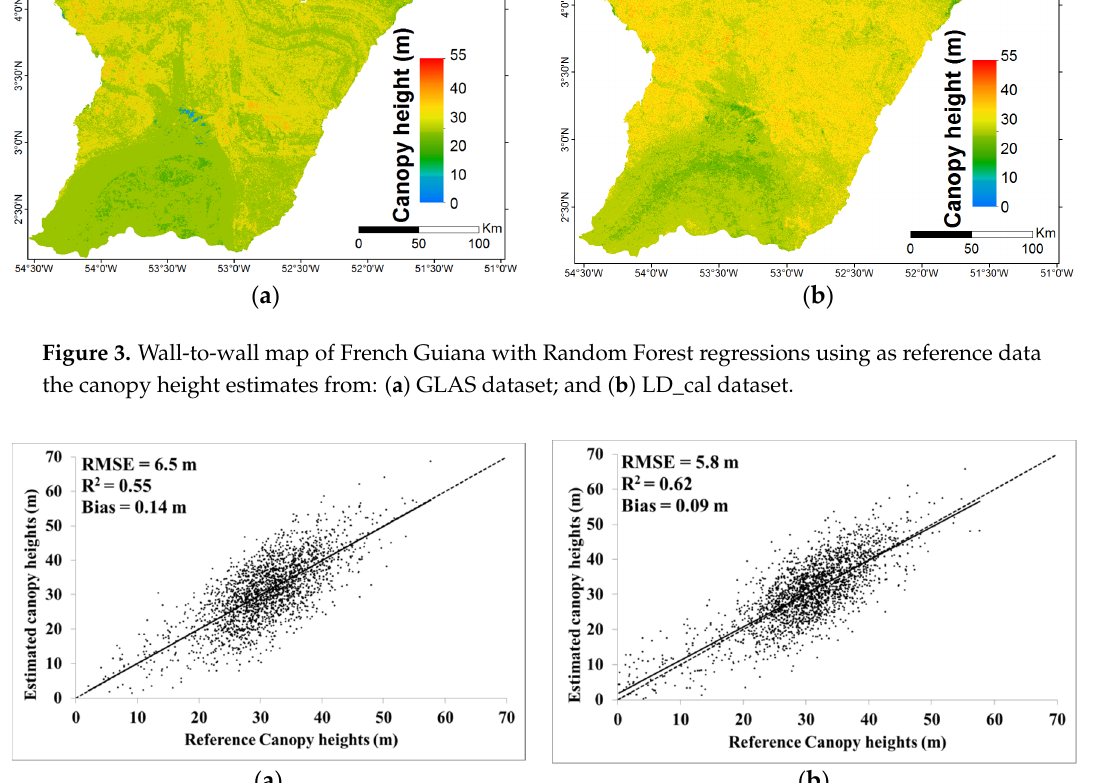
Figure 4. Comparison between the reference canopy heights of the verification datasets and the canopy height trend estimates using Random Forest: ( a ) GLAS dataset; and ( b ) LD_cal dataset. Table 2. Comparison between the canopy heights of the verification datasets (LD_val and HD) and the canopy height estimates using regression kriging. Using RF Only Using Regression